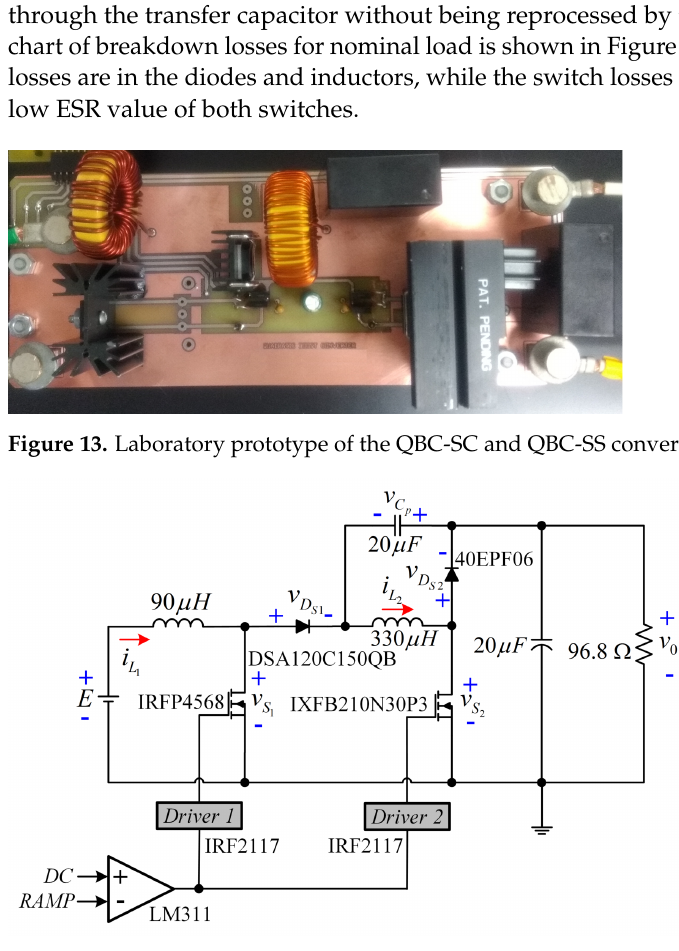
Figure 14. Experimental schematic for the proposed converter.